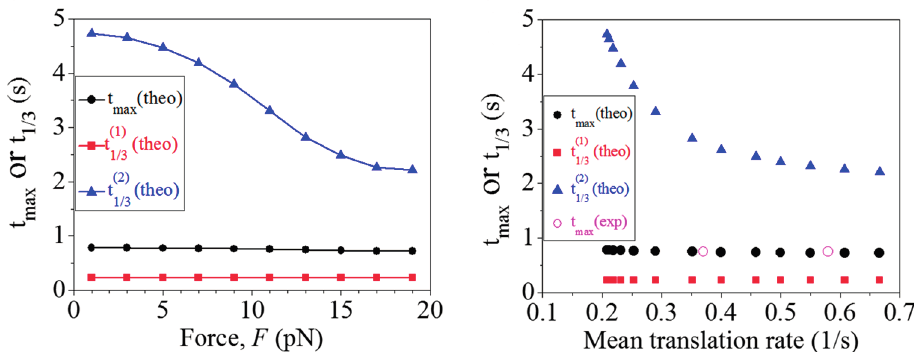
Figure 4. Dwell time, t max , at which the maximum value of the distribution occurs, dwell time, (1) t , at which the distribution increases from zero to the value equal to one third of 1 3 the maximal value, and dwell time, (2) obtained from Figure 5. The right panel corresponds to t max , (1)